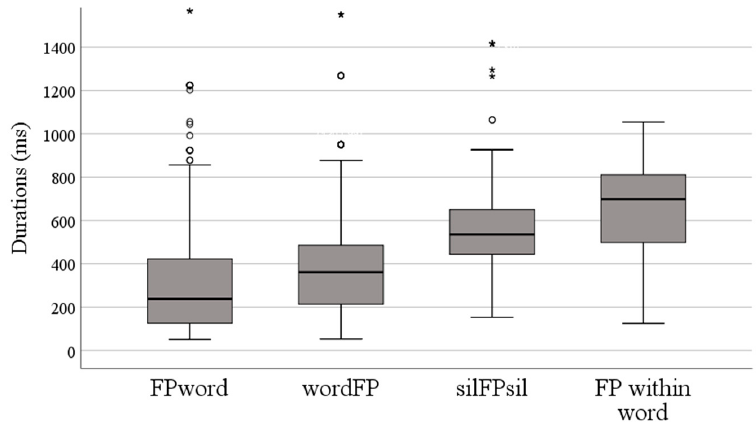
Figure 3. Durations of FPs according to their four positions (medians and interquartile ranges). (The asterisks and circles mark the outliers.)